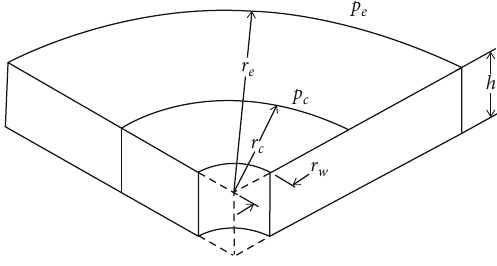
Figure 2: Circular fi nite oil reservoir model.